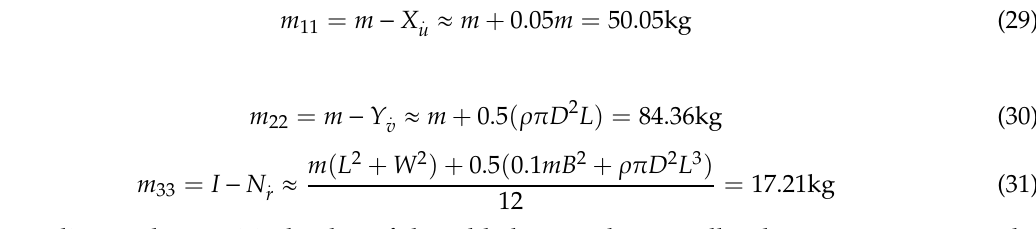
Figure 6. Relationship of initial acceleration, surge velocity, and propeller speed.